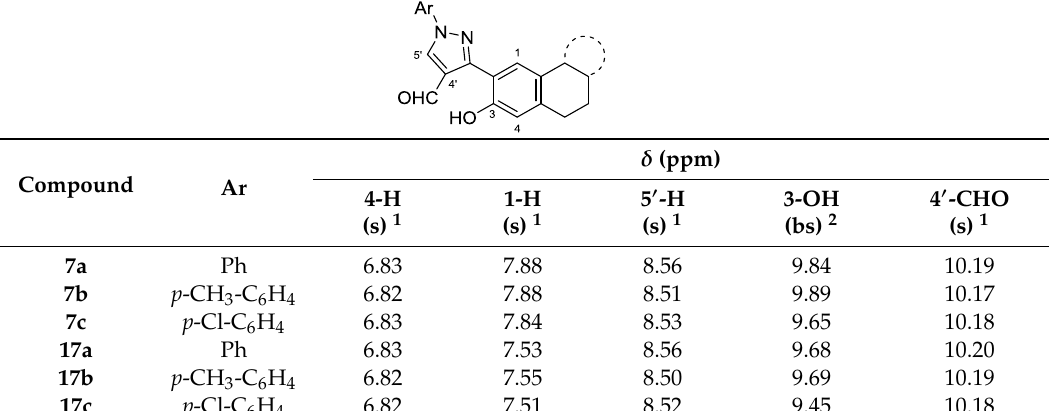
Table 2. Selected 1 H-NMR spectral parameters for steroidal ( 7a – c ) and non-steroidal 4-formylpyrazoles ( 17a – c ) in CDCl 3 at 500 MHz.